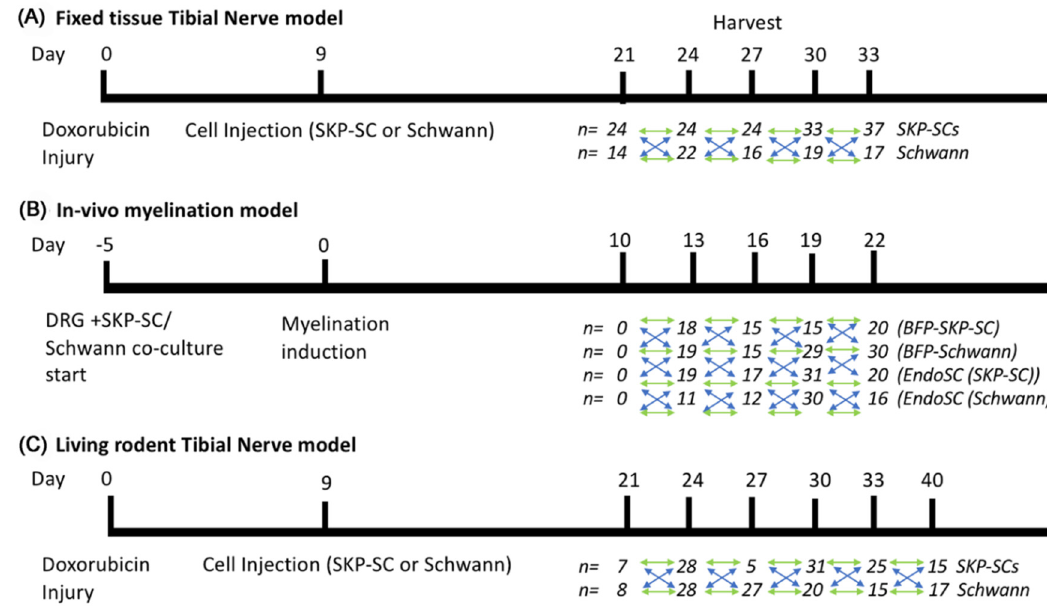
Figure 2. Experimental timelines for each experimental paradigm of exogenous or endogenous cell-derived myelination. ( A ) Timeline for fixed tissue analysis of injected skin-derived precursor Schwann cell (SKP-SC) and Schwann cell myelin within a tibial nerve doxorubicin injury model. ( B ) Timeline for an analysis of in vitro myelination provided by blue fluorescent protein skin-derived precursor Schwann cells (BFP SKP-SCs) and endogenous green fluorescent protein (GFP) Schwann cells (EndoSC (SKP-SC)) in co-culture with GFP-positive dorsal root ganglia (DRG) explants, alongside an analysis of BFP-Schwann cells and endogenous GFP Schwann cells (EndoSC (Schwann)) likewise in co-culture with GFP DRG explants. ( C ) Timeline for the analysis of living myelin by BFP-SKP-SCs and BFP-Schwann cells, by in vivo microscopy, in the same rodent tibial nerve doxorubicin injury model. Statistical comparison between cohorts in di ff erent experimental groups was performed via 2-way analysis of variance (ANOVA) with Tukey’s post-test (blue arrow relationships). Comparison between cohorts of the same experimental group were performed using 1-way ANOVA with Tukey’s post-test (green arrow